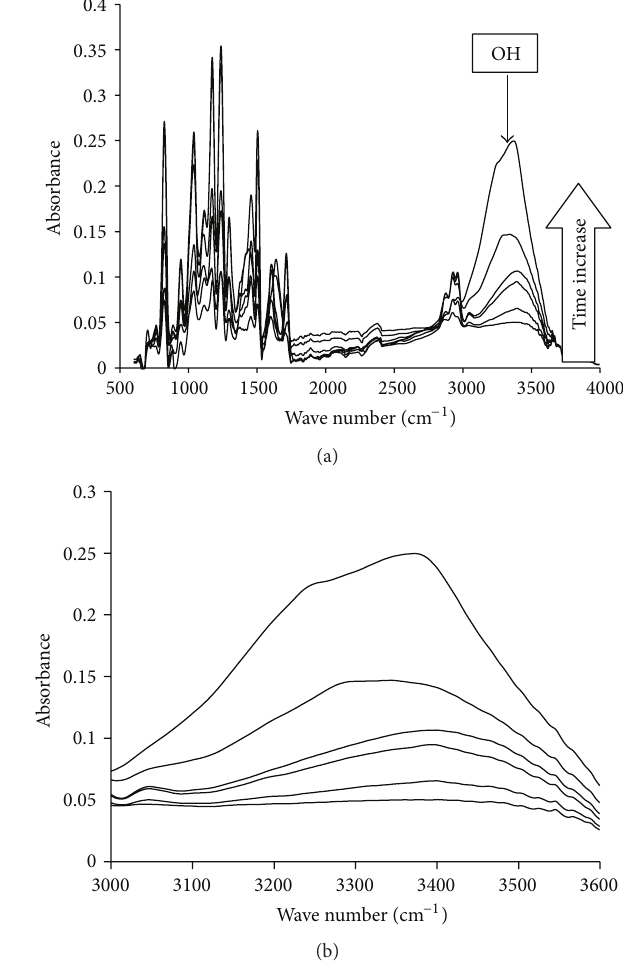
Figure 9: IR spectrogram: (a) vinylester and (b) details of band 3400 cm −1